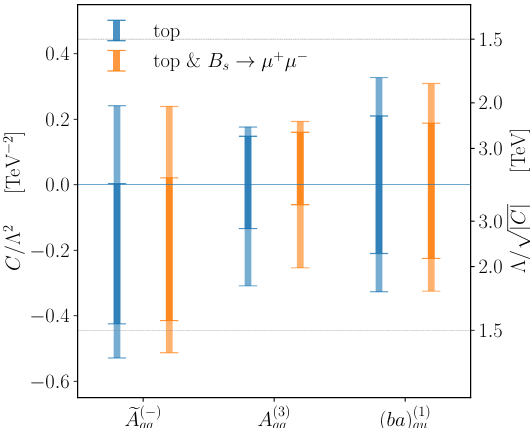
Figure 6 . Bounds on the four-quark Wilson coefficients C ( − ) qq ( m t ) = C (1) qq − C (3) qq , C (3) qq ( m t ) , and C (1) qu ( m t ) in MFV. Shown are the results from one-parameter fits of e A ( − ) qq , A (3) qq and ( ba ) (1) qu , see eqs. (3.15) and (3.16), to top observables (blue) and top & B shade) and 95% CL (light